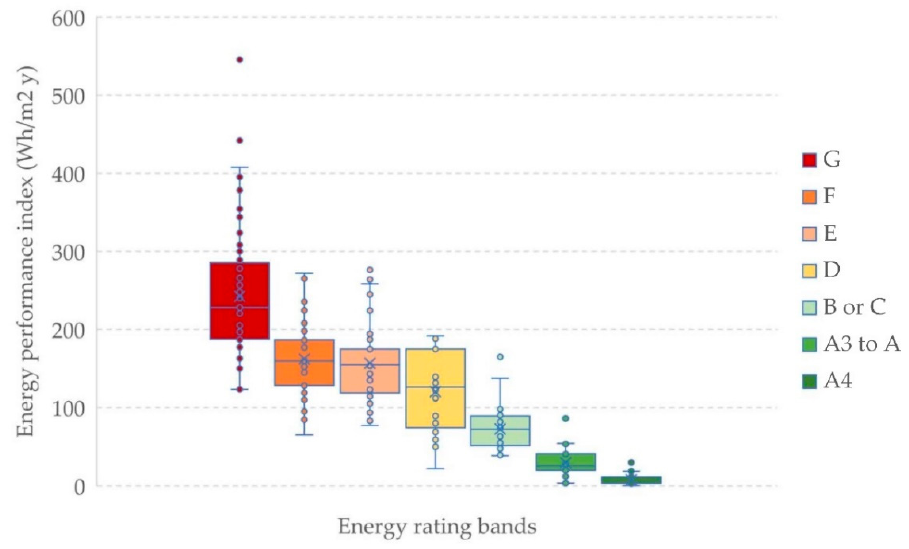
Figure 3. Inverse relationship between energy rating bands and the energy performance index.